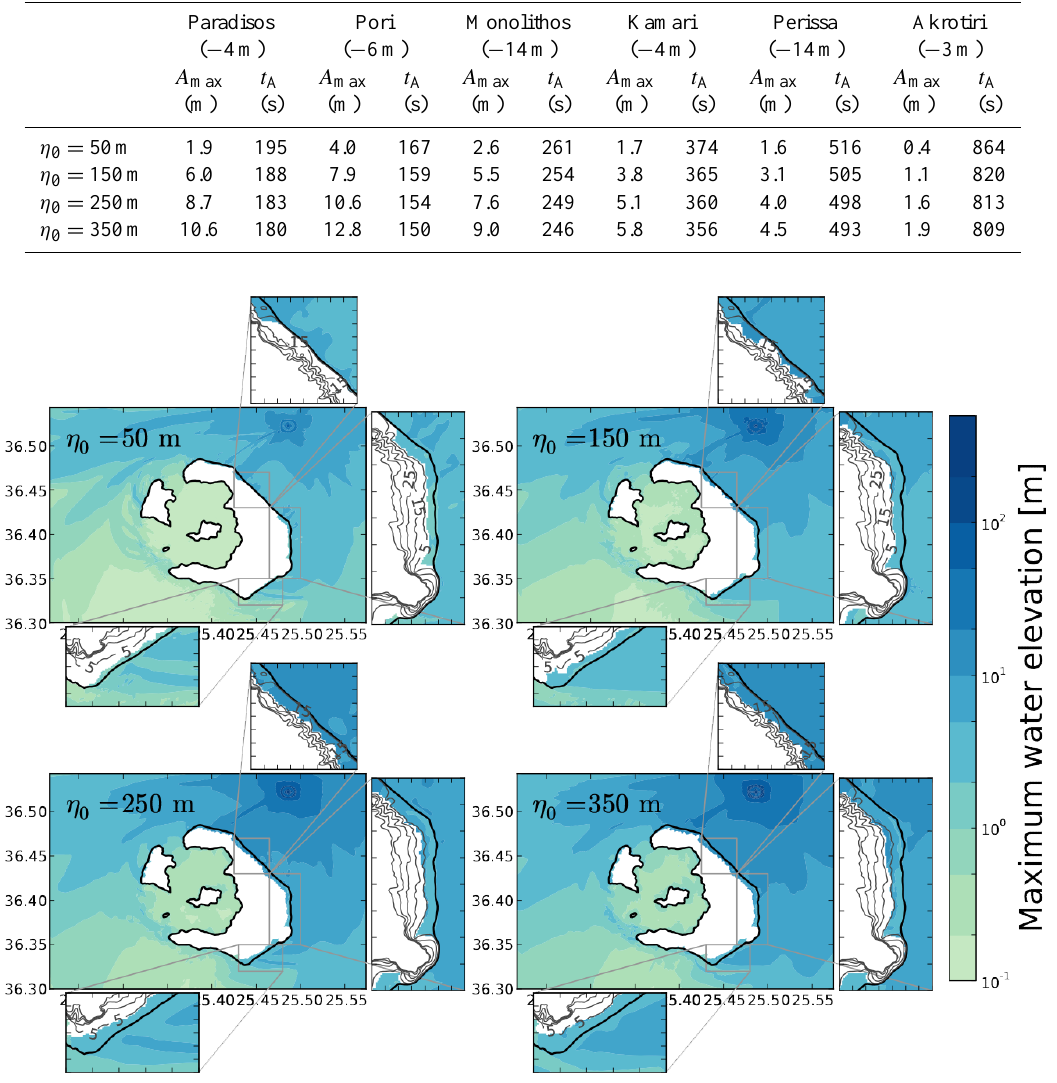
Fig. 9. Results of numerical calculations of the Kolumbo explosion generating tsunami. Maximum wave amplitudes around Santorini for several η 0 with zooming in the key coastal areas. Note, that the colour scale is logarithmic. Black thick solid line represents the original coastlines. Thin black lines in zooms are topography contours with 10m interval starting at 5m. Inundation of most east coast of Santorini is visible for all four